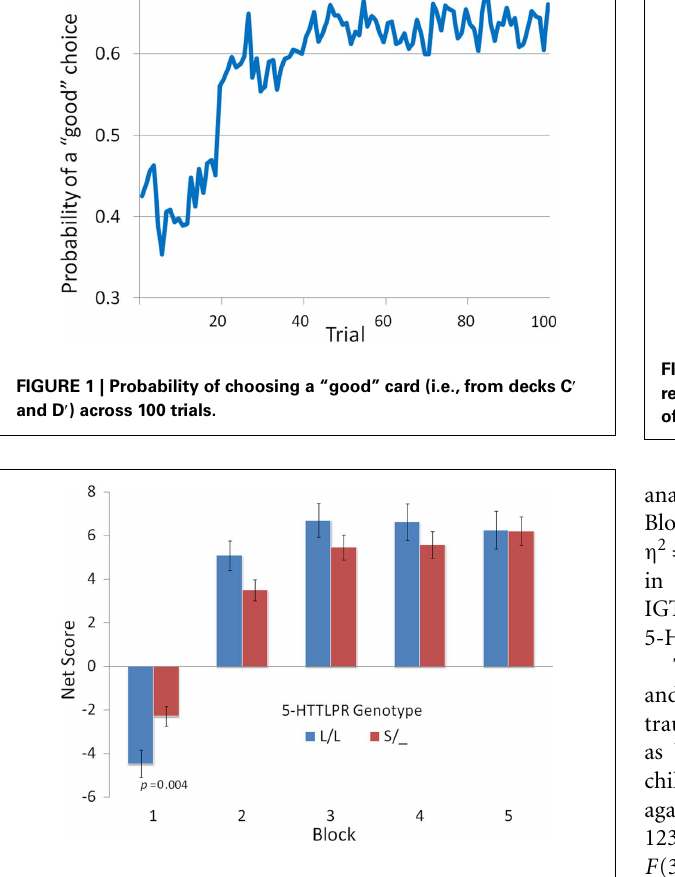
FIGURE 2 | Mean net score [(C (cid:2) + D (cid:2) ) − (A (cid:2) + B (cid:2) )] for groups defined by 5-HTTLPR genotype across five blocks of 20 trials.